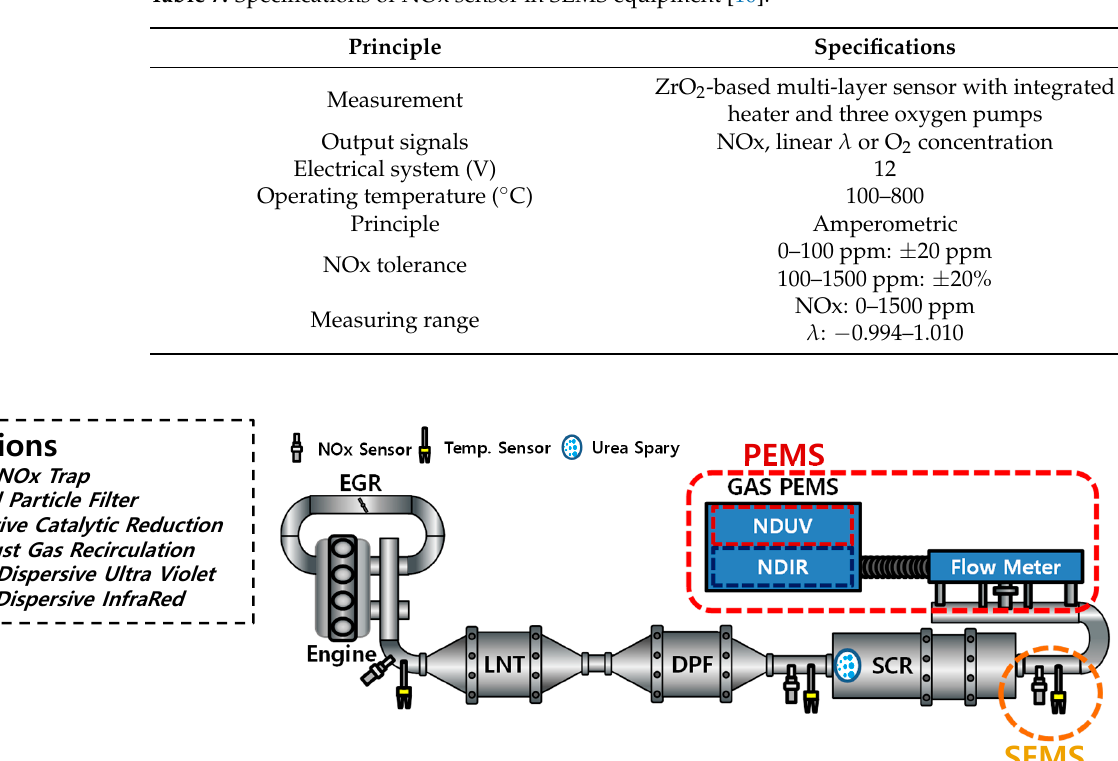
Table 7. Specifications of NOx sensor in SEMS equipment [10].